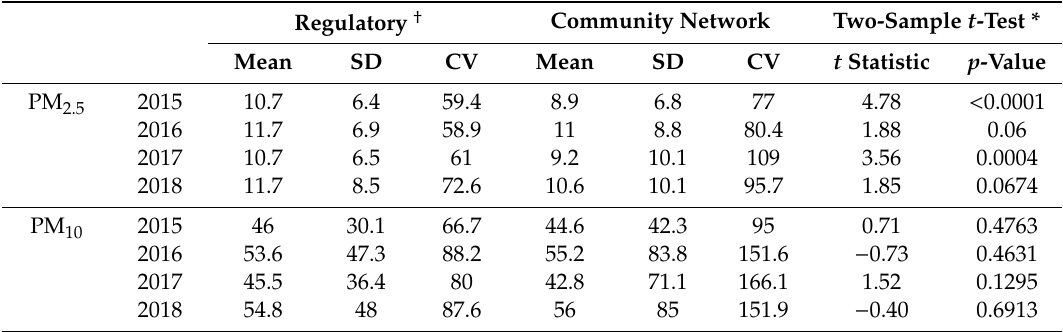
Table 1. Annual particulate matter 24-h averages, standard deviations, coe ffi cients of variation, two-sample t -test, and ordinary least squares (OLS) linear regression results. California Regulatory and Community Network Values, 2015–2018. Source: IVAN Network, U.S. EPA AWS.